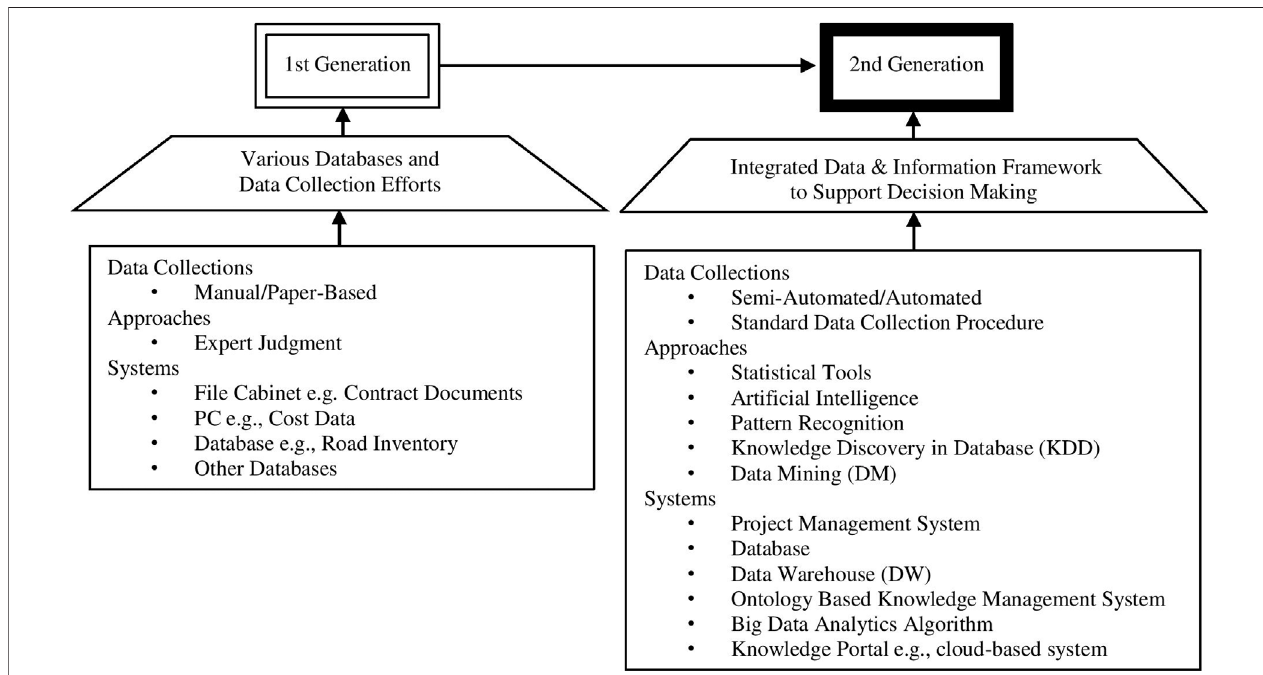
FIGURE 3 | Two generations of data and information management for construction projects.